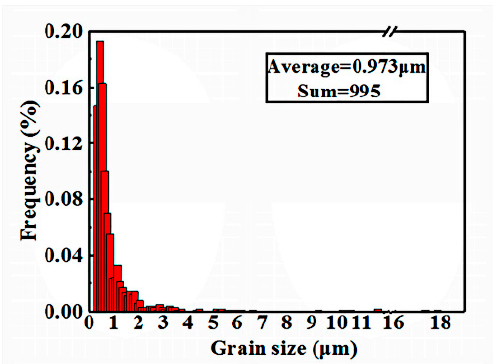
Figure 6. The cross-sectional electron backscattering diffraction (EBSD) orientation image after 25 pulse treatments.